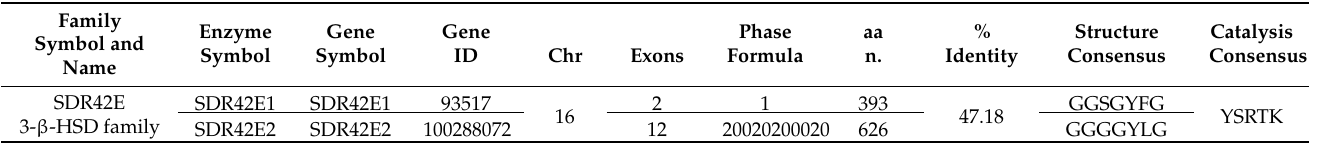
Table 5. Genetic and molecular data of the human SDR42E family variants. For further details, see Table 1.